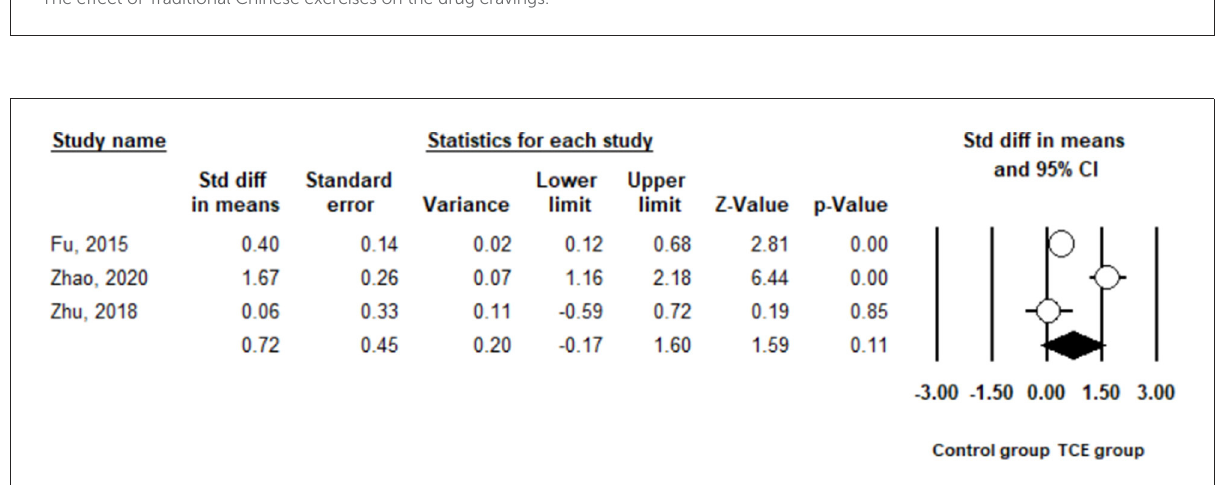
FIGURE7 The effect of Traditional Chinese exercises on the drug cravings.